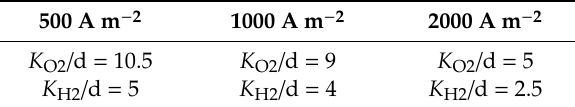
Table 3. Sensitivity study results for the parameter K